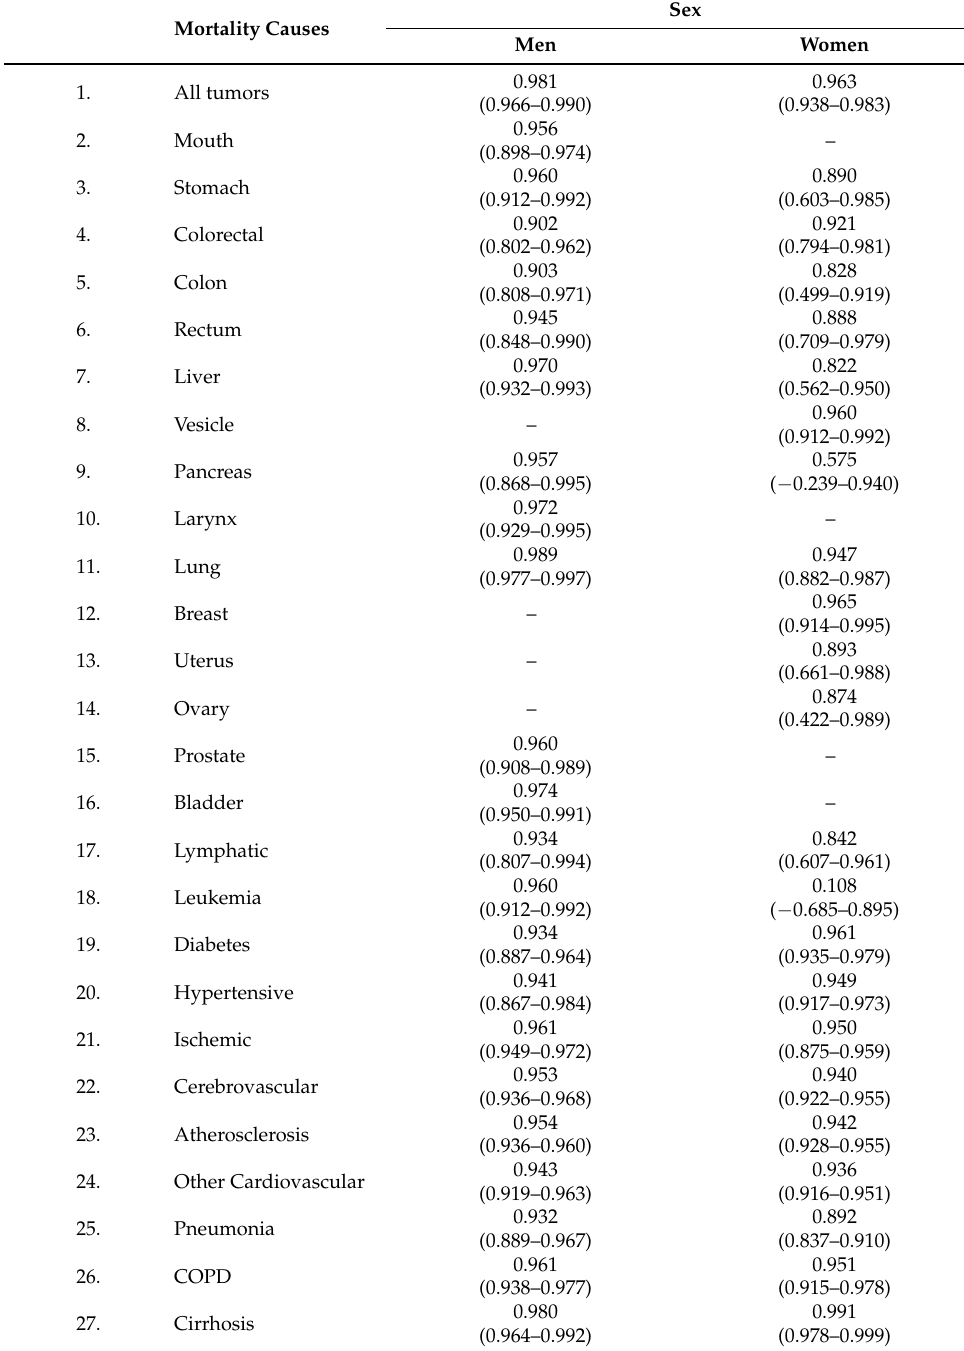
Table 1. Posterior mean and 95% credible interval for the temporal correlation coefficient ( ρ ) of the AR model for each mortality cause and